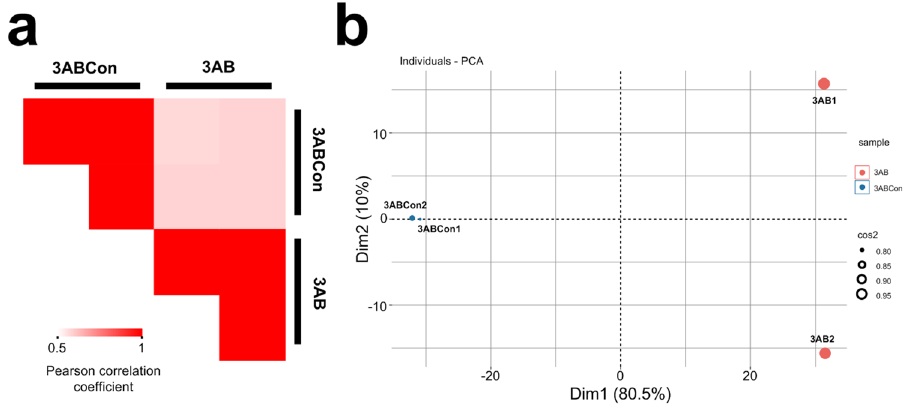
Figure 2. Correlation analysis and PCA of identified proteins in 3AB group and 3ABCon group. ( a ) The matrix of correlation plots revealed correlations between samples from 3AB group and 3ABCon group. ( b ) PCA of proteins detected in 3AB group and 3ABCon group.